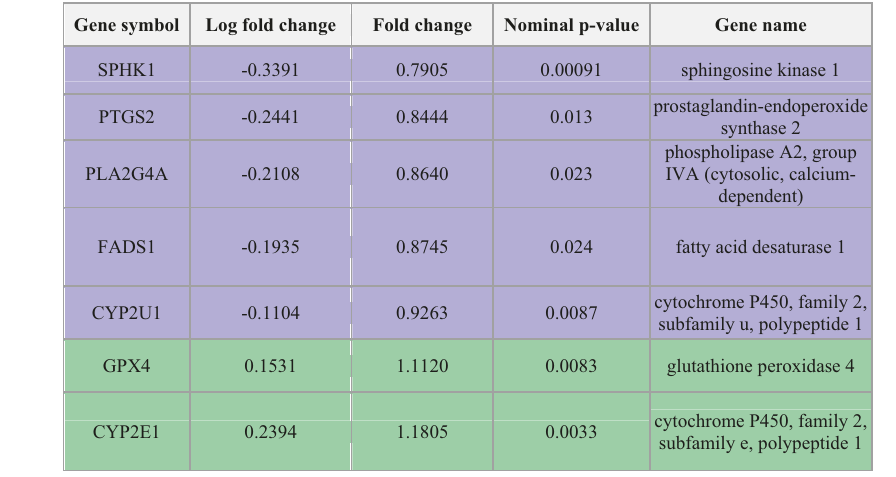
Table 2. Genes involved in arachidonic acid metabolism with signi fi cant p